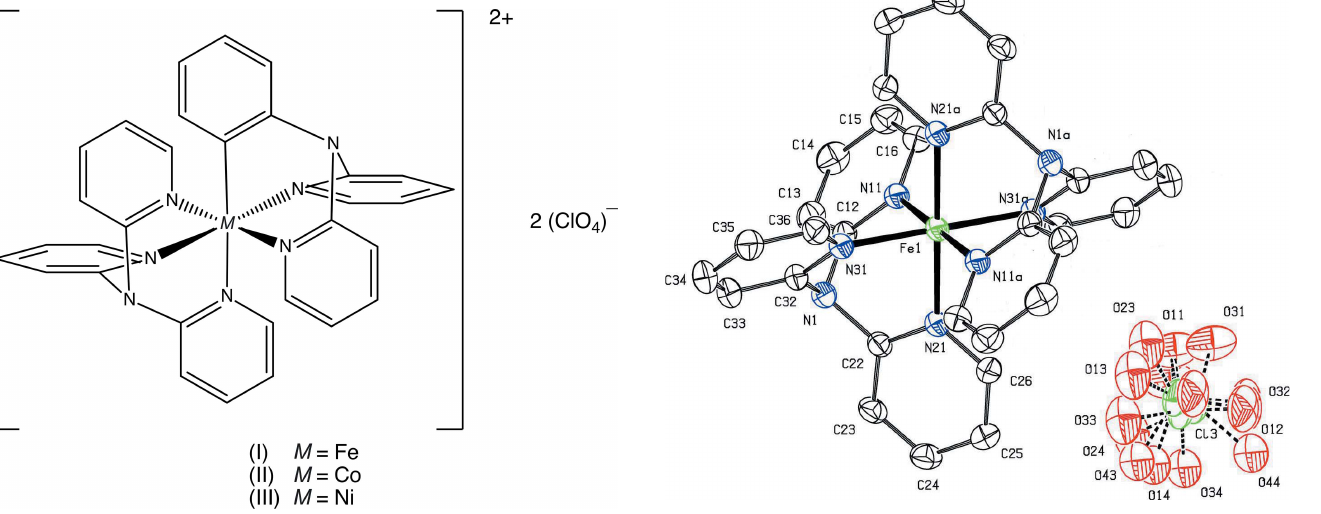
Figure 1 The ionic components of compound (I), with atom labelling and displacement ellipsoids drawn at the 30% probability level. For clarity, the H atoms and the symmetry-equivalent anion have been omitted, and unmarked atoms and atoms marked ‘a’ are at the symmetry position ( (cid:5) x + 1, (cid:5) y + 1, (cid:5) z + 1)